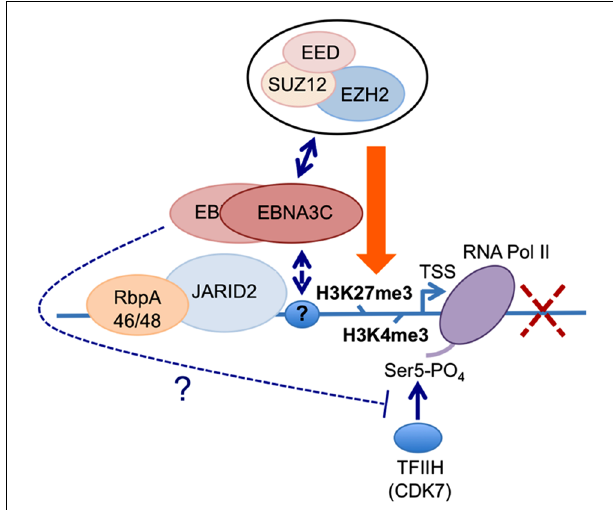
FIGURE 3 |Working hypothesis for the role(s) of EBNA3C and EBNA3A in the PRC2-mediated repression of the BIM promoter. The available data indicate that EBNA3C (and EBNA3A) are recruited to regions proximal to the BCL2L11/BIM transcriptional start site (TSS) in EBV-infected B cells (Paschos etal., 2012; our unpublished data and Figure 2 ). Irrespective of whether EBNA3C or EBNA3A are expressed in these cells, the PRC2-associated factors RbpA46/48 and JARID2 are present at the locus. Similarly the activation mark H3K4me3 and RNA polymerase II (RNA Pol II) occupy theTSS irrespective of which EBNA3s are expressed. Only when both EBNA3C and EBNA3A are present are core components of the PRC2 complex found at this site and the repressive chromatin mark H3K27me3 is detected across theTSS; concomitantly the level of transcription and BIM expression are reduced.The simultaneous presence of both H3K4me3 and H3K27me3 at the locus define it as a “bivalent” or “poised” domain and is consistent with RNA Pol II always being detected. However only in the absence of either EBNA3C or EBNA3A is RNA Pol II phosphorylated on serine residue 5 (RNA Pol II Ser 5), suggesting that in addition to playing a key role in the recruitment of PRC2 core complex, the presence of EBNA3C and EBNA3A might interfere with serine 5 phosphorylation of RNA Pol II and therefore block the initiation of transcription. Since EBNA3A and EBNA3C can be co-immunoprecipitated from infected B cells and both are necessary for repression of BIM (and p16 INK4a ) expression, in this model we assume they are co-localized at these loci.The identity of the factor(s) responsible for targeting EBNA3C and/or EBNA3A to this particular stretch of chromatin is still unknown, as is the mechanism of interaction with